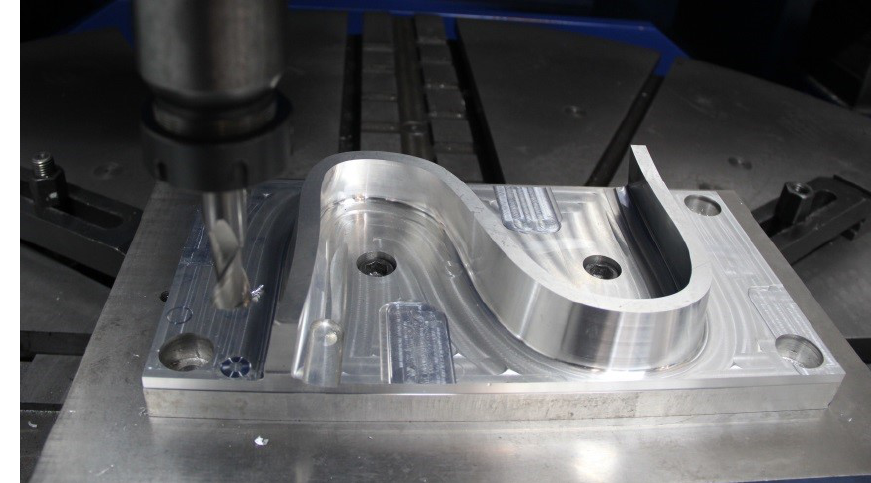
Figure 19. Machining results of S-shaped